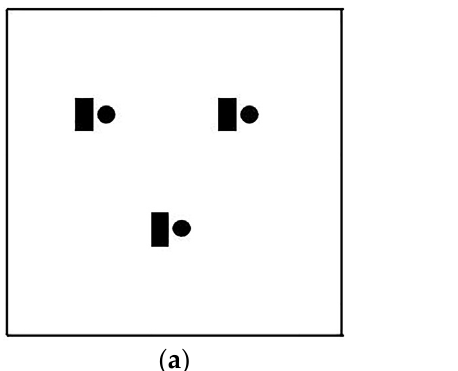
Figure 6. Test point arrangement: ( a ) inside of wall panel; ( b ) outside of wall panel.